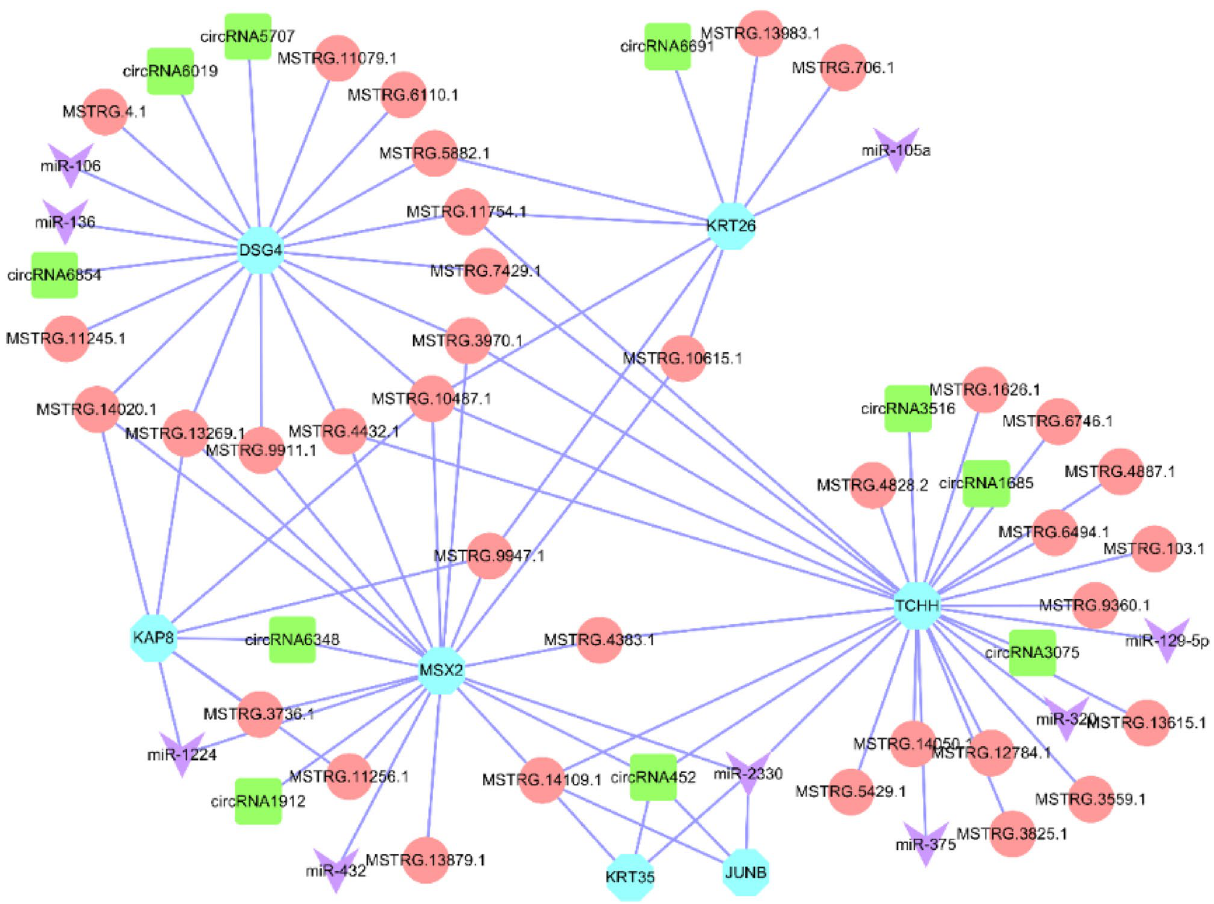
Figure 10. CeRNA networks of 7mRNAs, 35lncRNAs, 10circRNAs and 9miRNAs. Pink: lncRNAs, green: circRNAs, blue: mRNAs, purple: